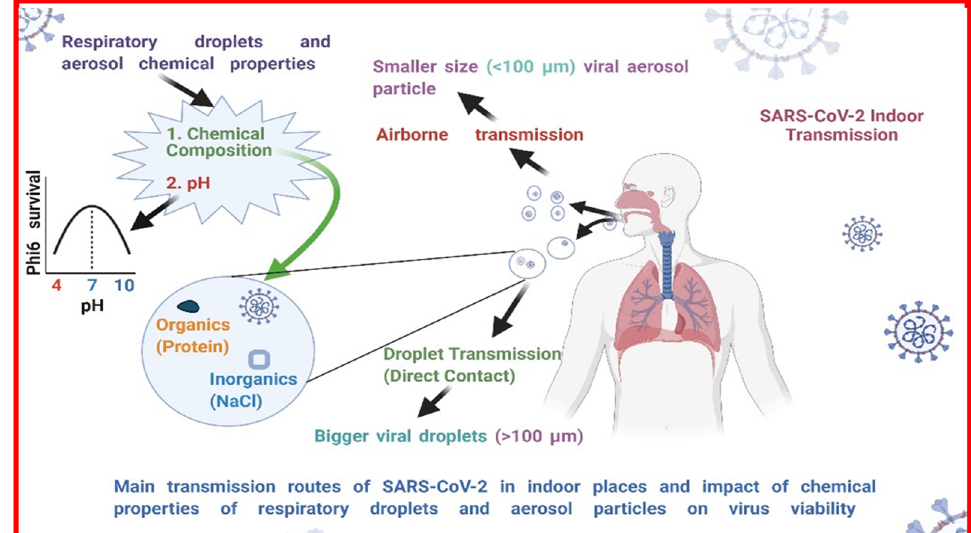
Figure 1. The impact of chemical properties of viral aerosol particles and droplets on the indoor transmission of SARS-CoV-2. The main transmission routes of SARS-CoV-2 in indoor environments are either due to droplets (direct contact) or aerosol particles (airborne transmission). The chemical composition and pH are important chemical properties that impact SARS-CoV-2 viability in expelled droplets. The chemical composition typically represents proteins, and NaCl along with the virus in a viral expelled fluid. Here, from the literature, we also report how pH values impact virus survival, Phi6 bacteriophage tested at different values of pH [13].